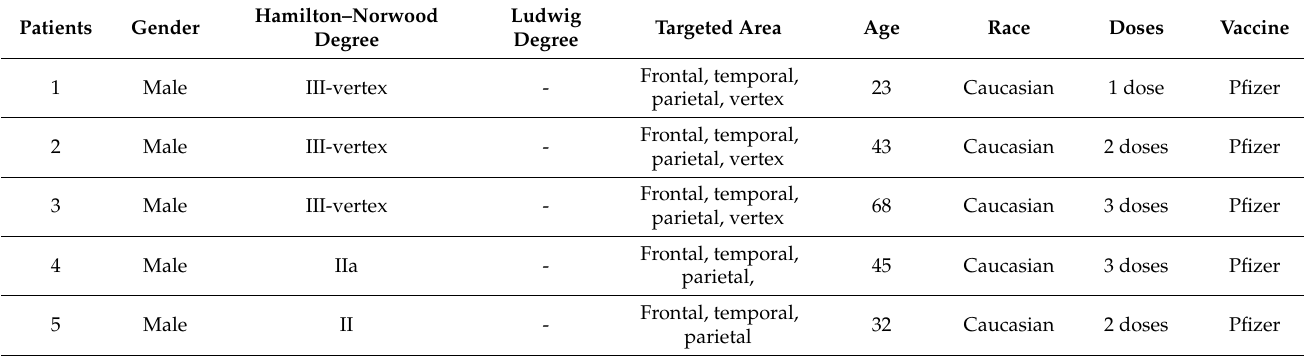
Table 1. Patient